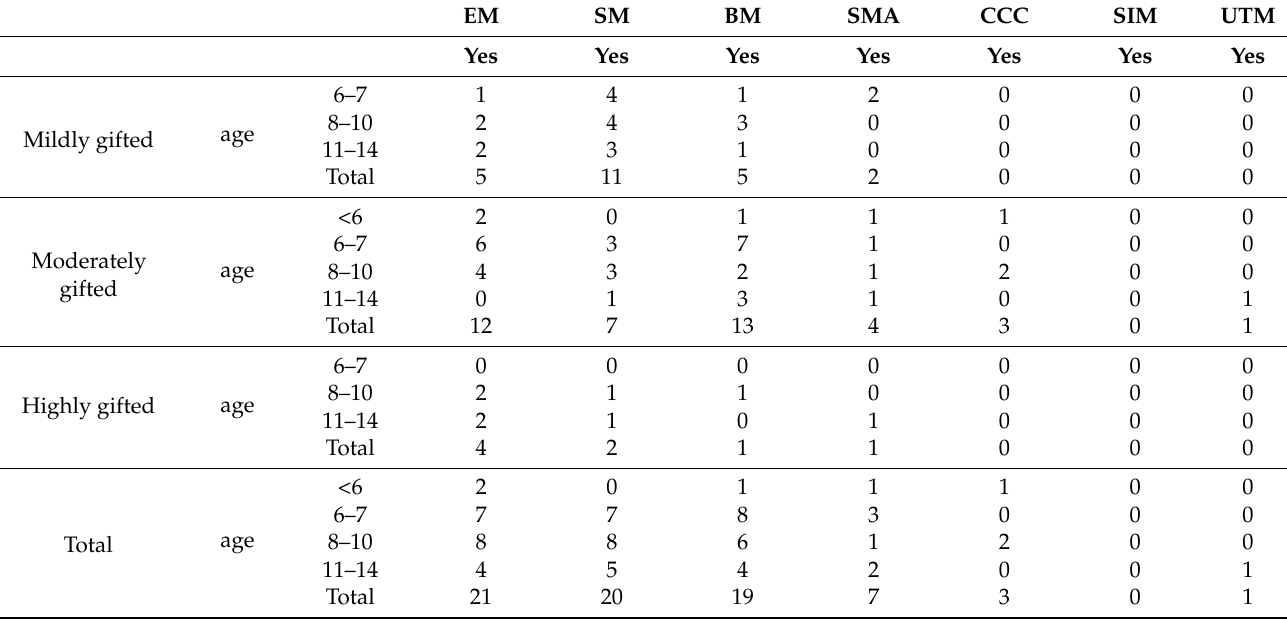
Table 7. Parenting educational